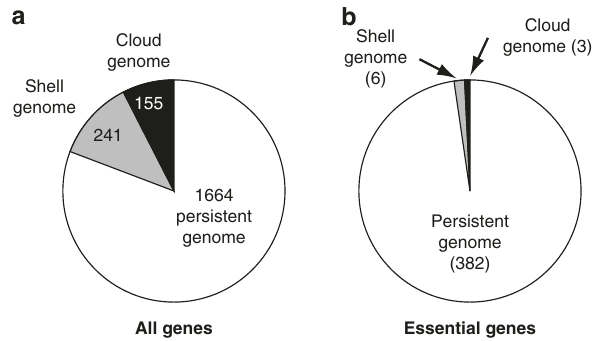
Fig. 2 Partition of essential meningococcal genes into persistent, shell and cloud genomes. To perform this analysis, we used the PPanGGOLiN 21 method as explained in the text. a Partition of the 2060 genes in the genome of N. meningitidis 8013: persistent (not highlighted), shell (highlighted in grey), and cloud (highlighted in black). The corresponding datasets are listed in Supplementary Data 5. b Partition of the subset of 391 essential genes identi fi ed in this study (same colour code than in a ). The corresponding datasets are listed in Supplementary Data 5.